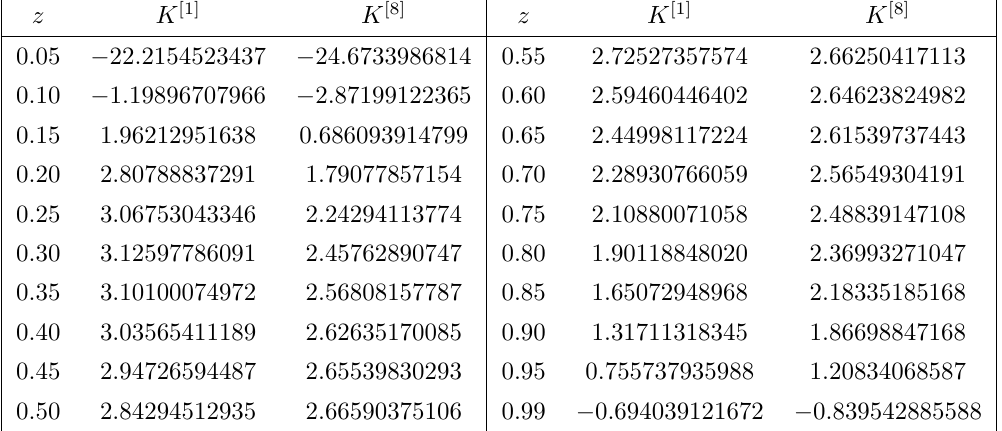
Figure 7 . SDCs of the fragmentation functions of g ! b (cid:22) b ( 1 S [1] The dotted line is for d [1] ) and the dashed line is for (6 m 3 b The superscript [1] or [8] respectively denotes the color-singlet or color-octet states of b (cid:22) b .